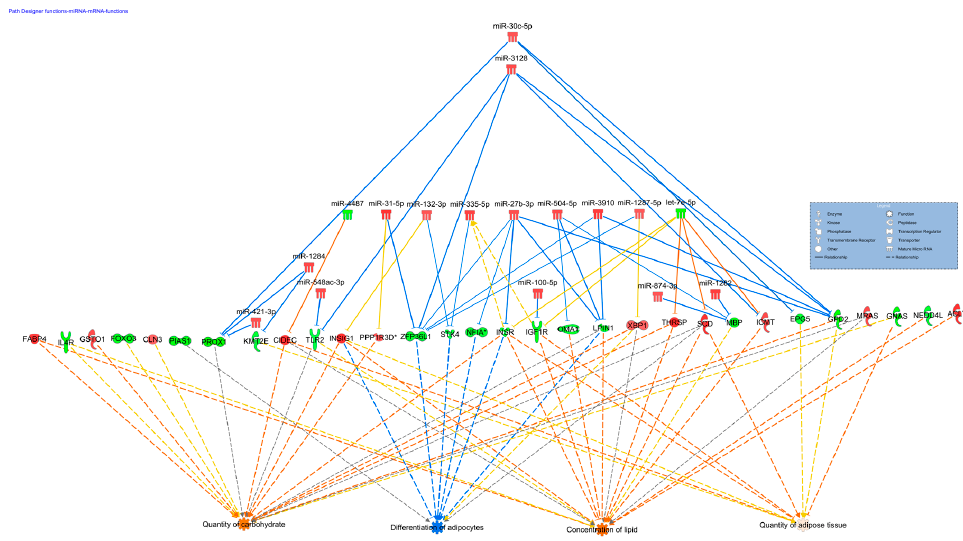
Figure 1. MicroRNA-target gene co-expression network constructed using Ingenuity Pathway Analysis (IPA). Here, upregulation and downregulation of microRNA (miRNA)/gene are represented by red and green, respectively. The intensity of color represents the level of expression, e.g., intense red means higher expression, while light red is low expression of a miRNA or DEG. The gene inhibition and activation by miRNA is shown by blue and orange lines, respectively. Further, predicted targets of the miRNAs are connected with yellow lines. Transcription factors, receptors, mature miRNA etc. are represented by different shapes in a blue box on top right of the image.